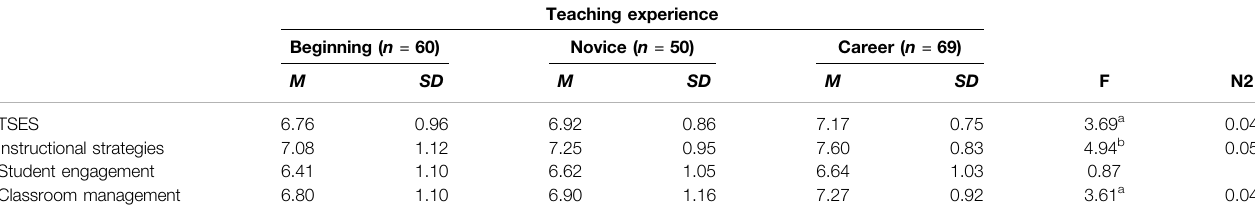
TABLE 4 | Means, standard deviations, and one-way analyses of variance in teaching self-ef fi cacy by teaching experience.